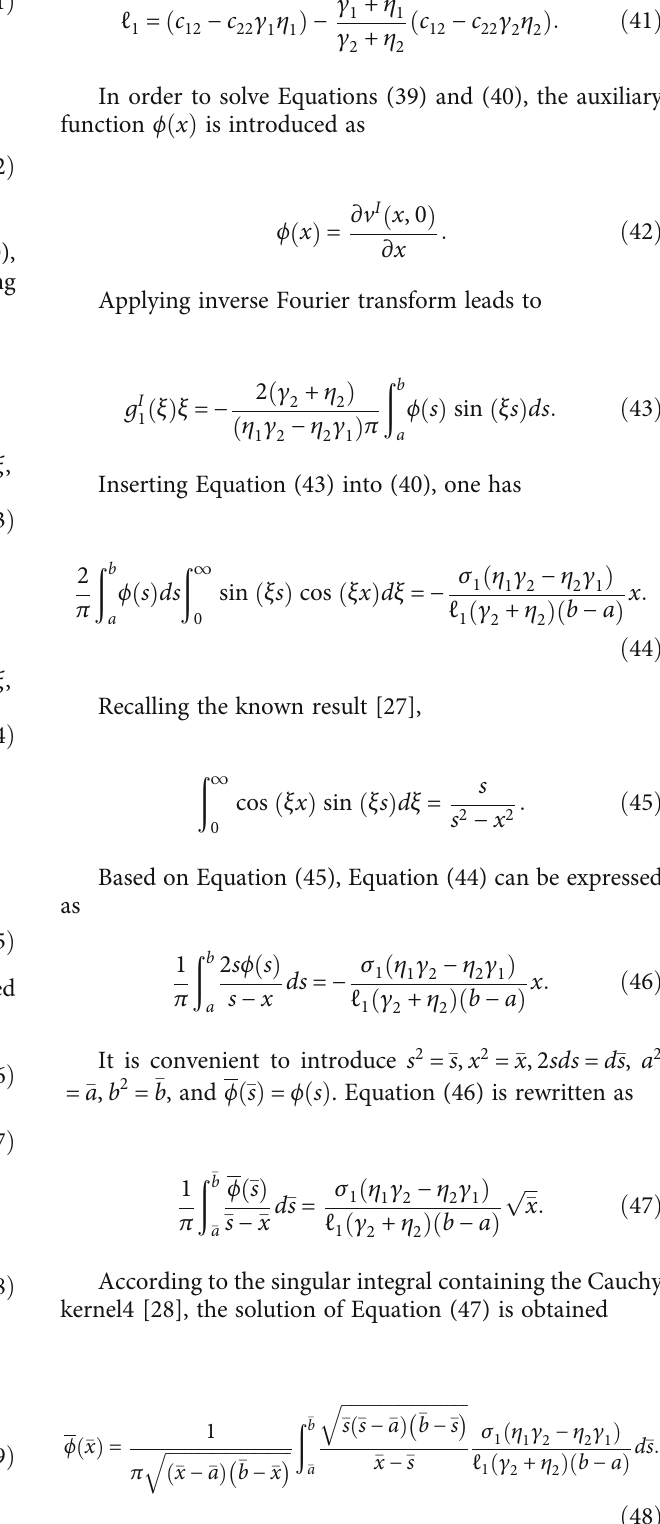
ffiffiffiffiffiffiffiffiffiffiffiffiffiffiffiffiffiffiffiffiffiffiffiffiffiffiffi